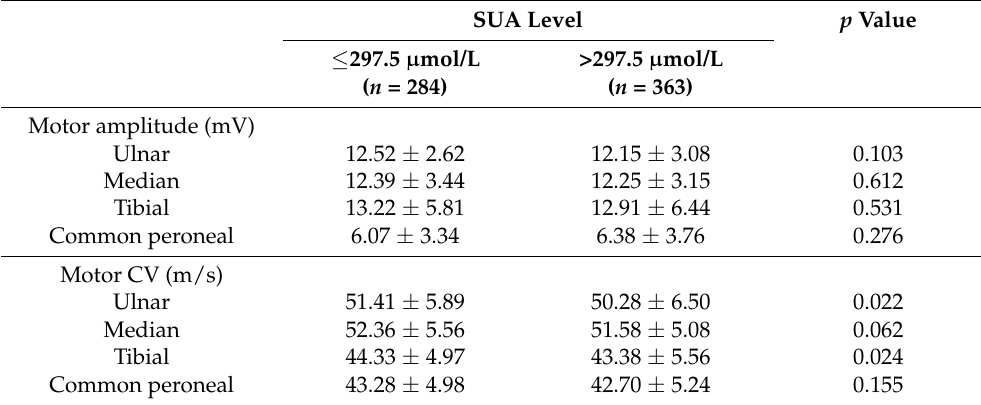
Table 4. Comparison of the nerve conduction studies parameters between subgroups based on the optimized cut-off of SUA